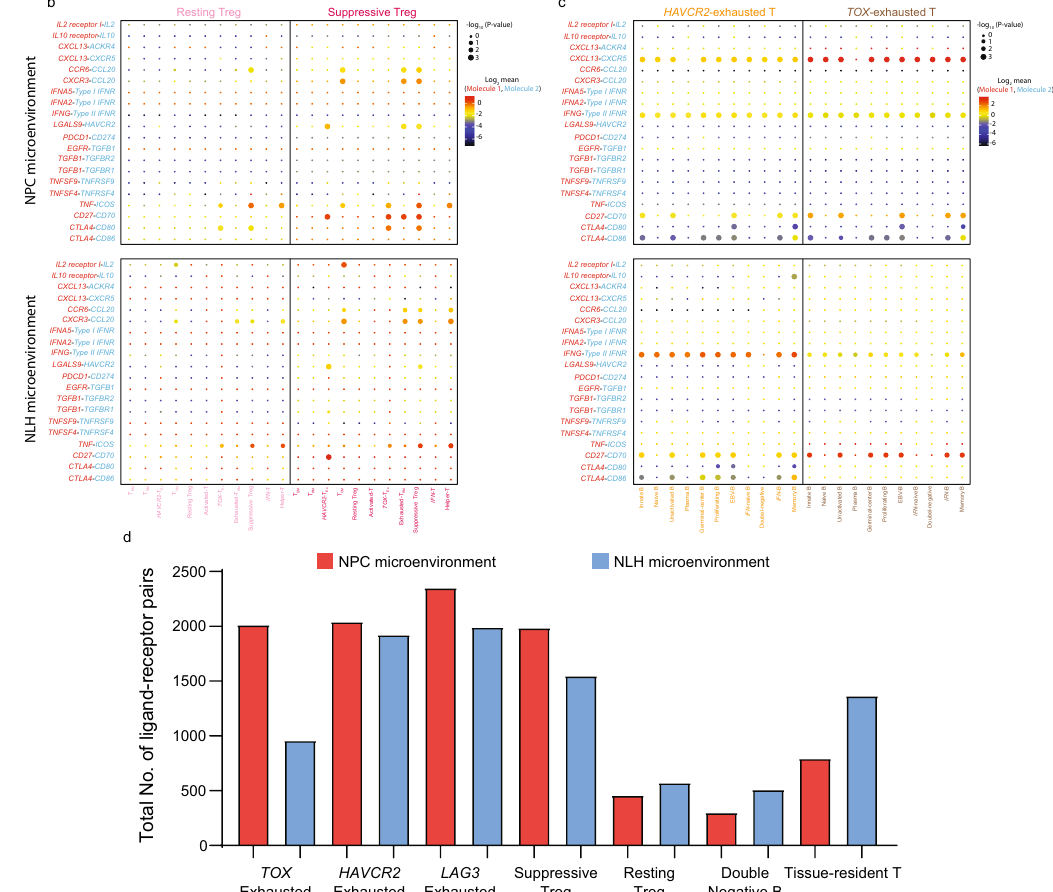
Fig. 9 Single-cell referenced communication analysis exhibits tumor-speci fi c ligand – receptor interactions within T and B cell subpopulations. a The cell-cell communications within major T and B cell subpopulations in the NPC microenvironment and NLH microenvironment, shown by chord diagram, colored by cell subtypes. The size of the arc represented the total number of ligand – receptor pairs, and the size of the fl ow represented the number of ligand-receptor pairs between two cell subtypes. b Overview of selected ligand-receptor interactions between resting Treg/suppressive Treg and functional T cell subpopulations, c between HAVCR2 exhausted T cells/ TOX exhausted T cells and all B cell subpopulations. p values were calculated using the two-sided Student ’ s t test with 95% CI and refer to the enrichment of the interacting ligand-receptor pair in each of the interacting pairs of cell types. Log 2 mean referred to the strength of a speci fi c ligand-receptor connection in the corresponding cell types. d The total number of ligand-receptor pairs in the NPC-derived and NLH-derived T and B subpopulations. Source data are provided as a Source Data fi